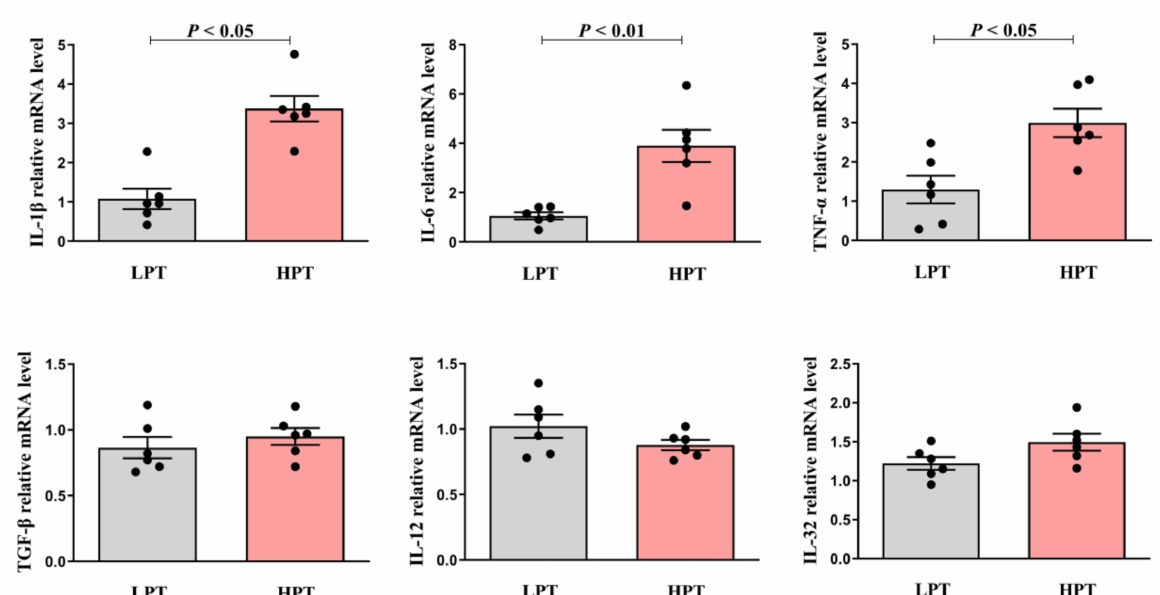
Figure 1. Effects of low and high NFC to NDF ratio pelleted TMR on mRNA level of proinflammatory cytokines in